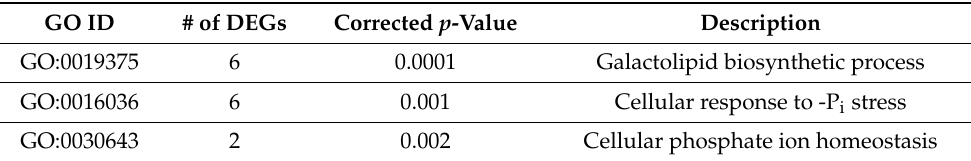
Overrepresented biological process Gene Ontology (GO) terms identified in VIGS_Glyma.05G001700 leaf samples in response to iron availability (FeS vs. FeD).